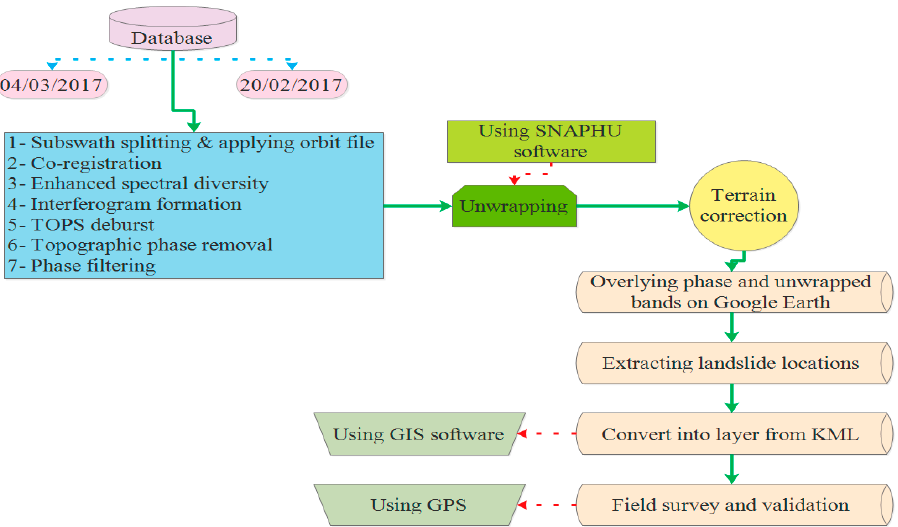
Figure 4. Step-by-step for assessment of landslides in study.